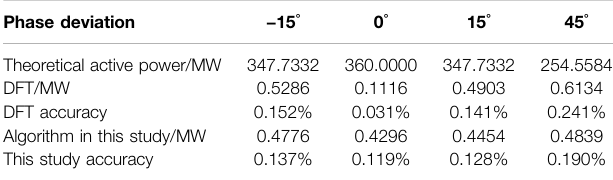
TABLE 2 | Maximum deviation of active power measurement.